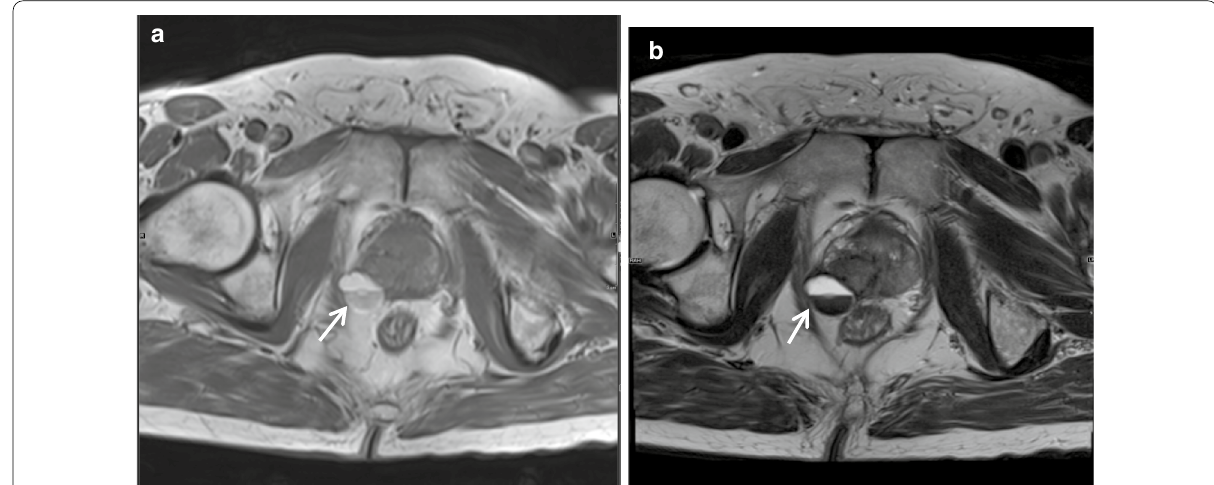
Fig. 6 Periprostatic haematoma post-biopsy a Axial T1W and ( b ) T2W images demonstrate a right posterolateral periprostatic haematoma (white arrow) post-biopsy which is high signal on both sequences with a fluid–fluid level